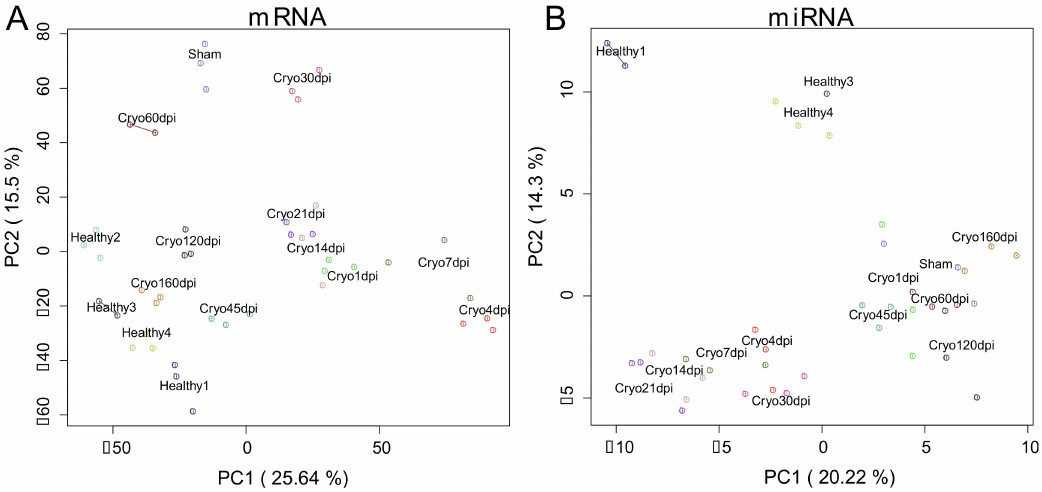
Figure 2. Principal component plots of log2-expression (counts per million) of ( A ) mRNA samples and ( B ) miRNA samples. For each sample RNA was extracted from 3–5 zebrafish hearts and both mRNA and miRNA were